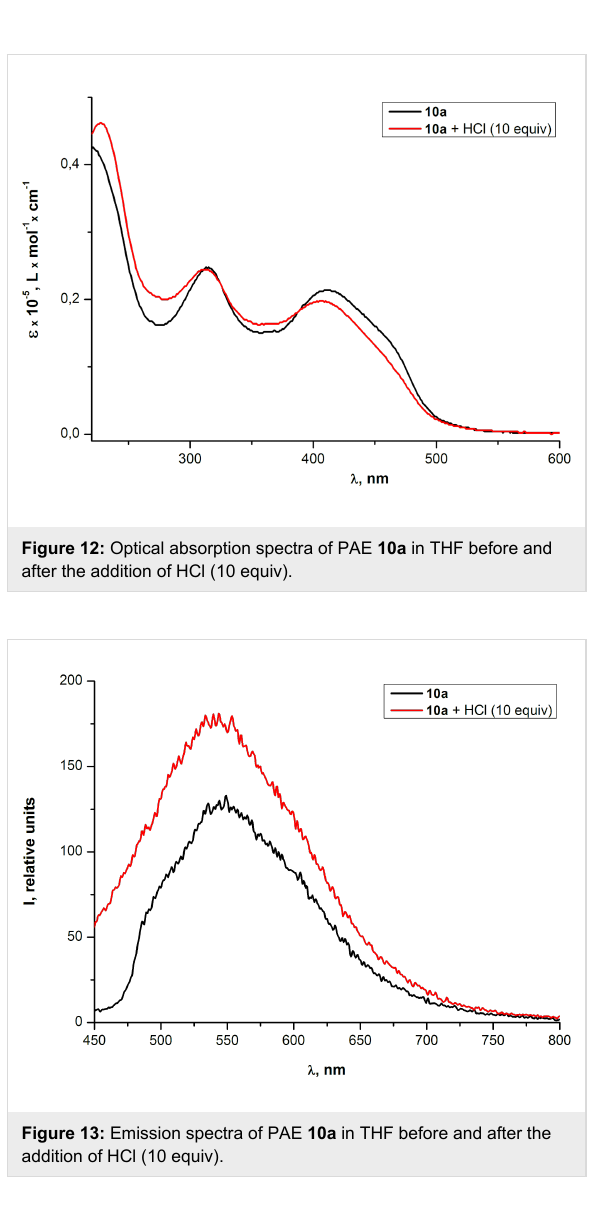
conjugated triple bonds (and/or the additional ethynyl moiety in the case of compound 10b ) and a cinnoline ring. In order to determine the role of the cinnoline fragment in this process, UV–vis and fluorescence emission